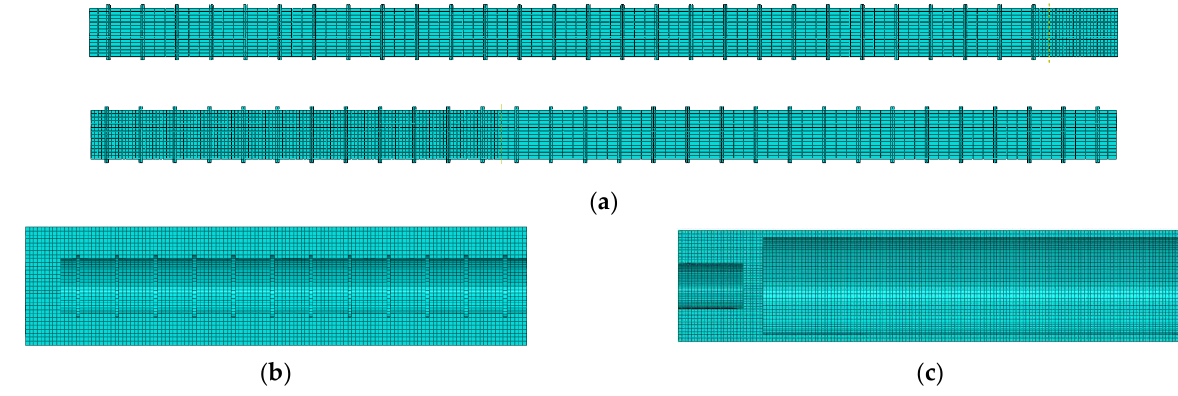
Figure 18. Mesh subdivision. ( a ) Rebar. ( b ) Grouting material. ( c ) Sleeve.